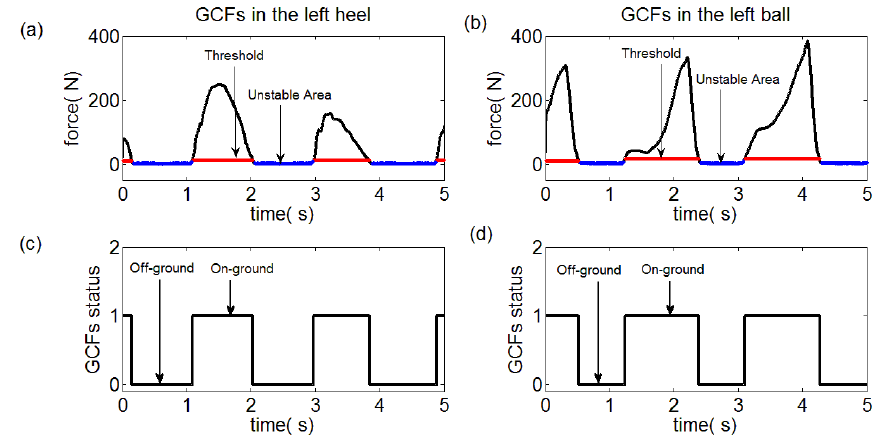
Figure 11. Status division for left ball and heel. ( a ) GCFs in the left heel, ( b ) GCFs in the left ball, ( c ) Status division for GCFs in the left heel, ( d ) Status division for GCFs in the left ball.